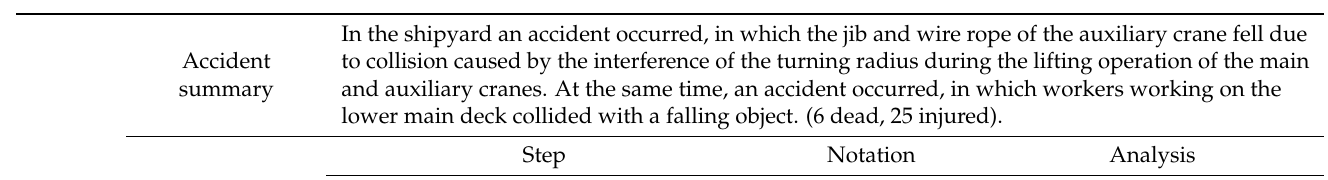
Table 4. Representative actual cases of accidents caused by multiple processes in the workplace—